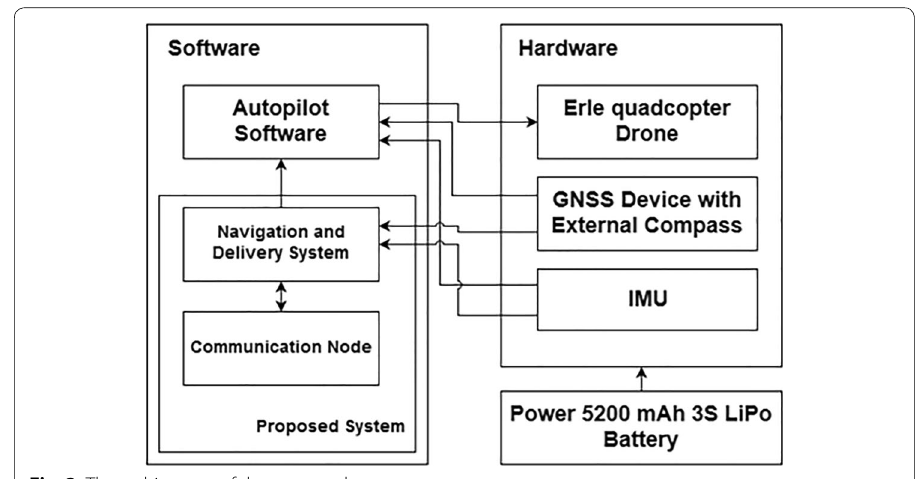
Fig. 3 The architecture of the proposed